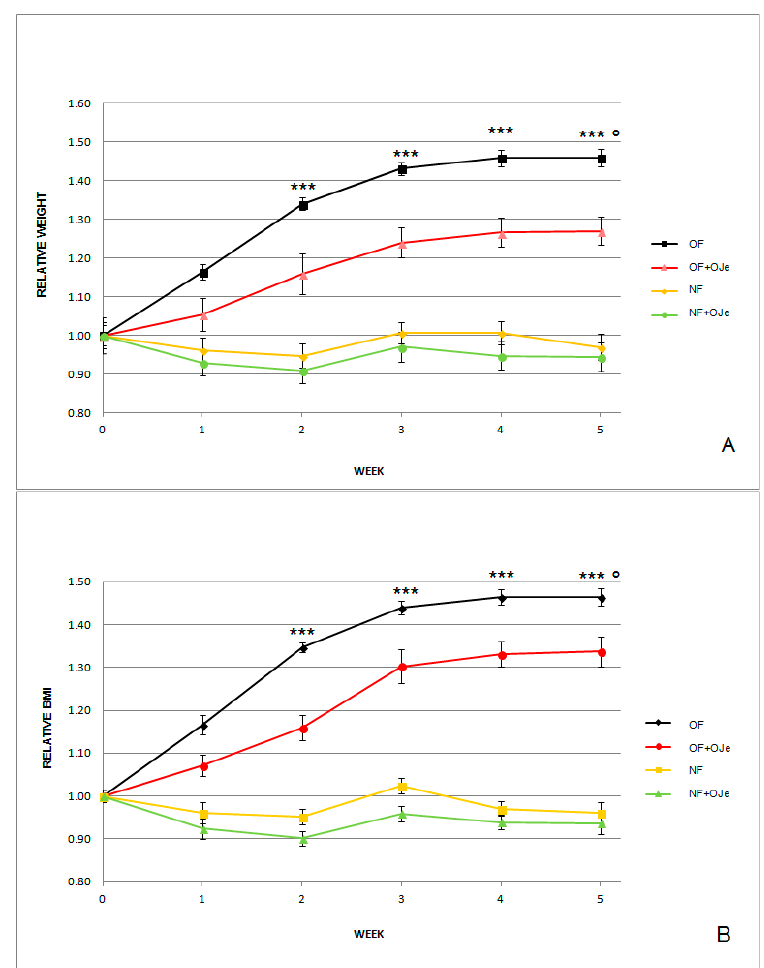
Figure 1. Effects of the orange juice extract (OJe) on both normalized body weight (BW) and body mass index (BMI) in overfed (OF) and normally fed (NF) zebrafish. Graphs show the fold change of BW ( A ) and BMI ( B ) values recorded each week during the five experimental weeks. Results are expressed as mean ± SD of data collected from 15 animals per experimental group. BW and BMI relative values were extrapolated from the data detected in the fish at T 0 for each group, which were arbitrarily expressed as 1. At T 0 , the BW values were the following (g): 0.44 in OF, 0.49 in OF supplemented with OJe (OF + OJe), 0.54 in NF, and 0.45 in NF supplemented with OJe (NF + OJe) groups. The BMI values (g/cm 2 ) at T 0 were 0.027 and 0.030 in the OF and OF + OJe groups, respectively, while they were 0.031 and 0.030 in the NF and NF + OJe groups. *** p < 0.001 vs OF + OJe; ° p < 0.001 vs NF.